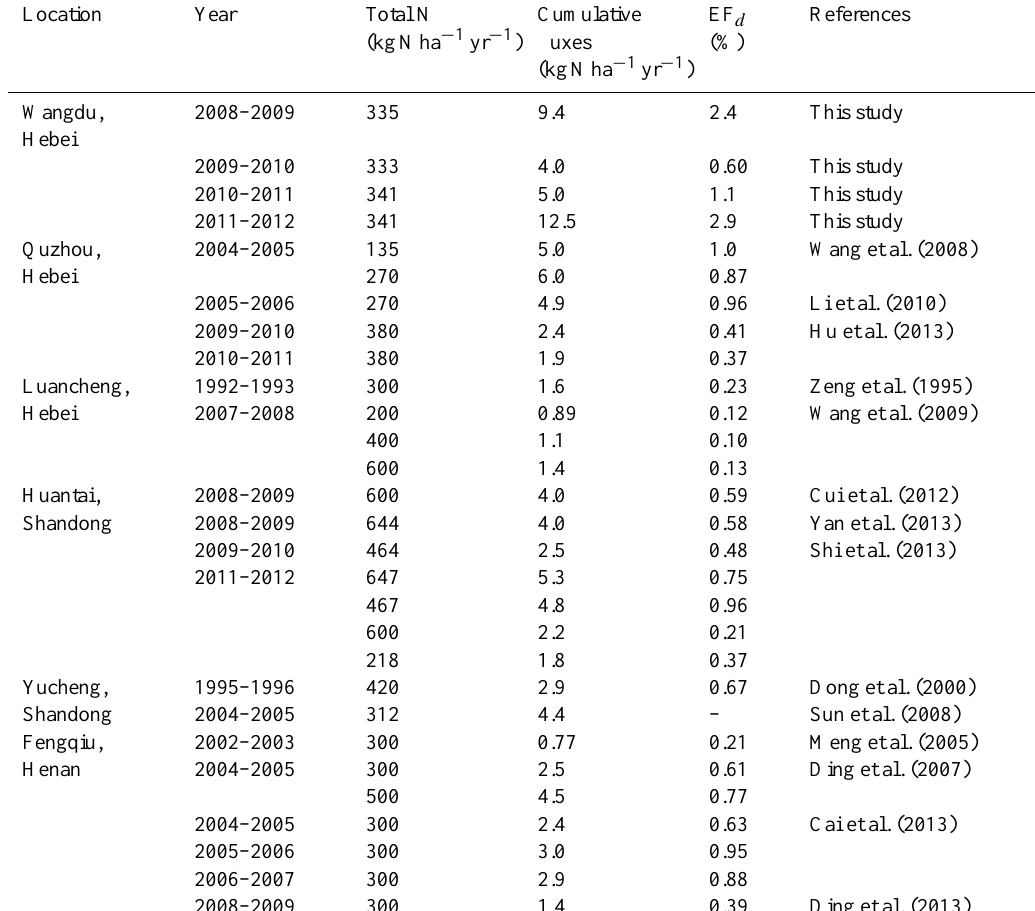
Table 4. Summary of N 2 O emissions from maize–wheat soils in the NCP.